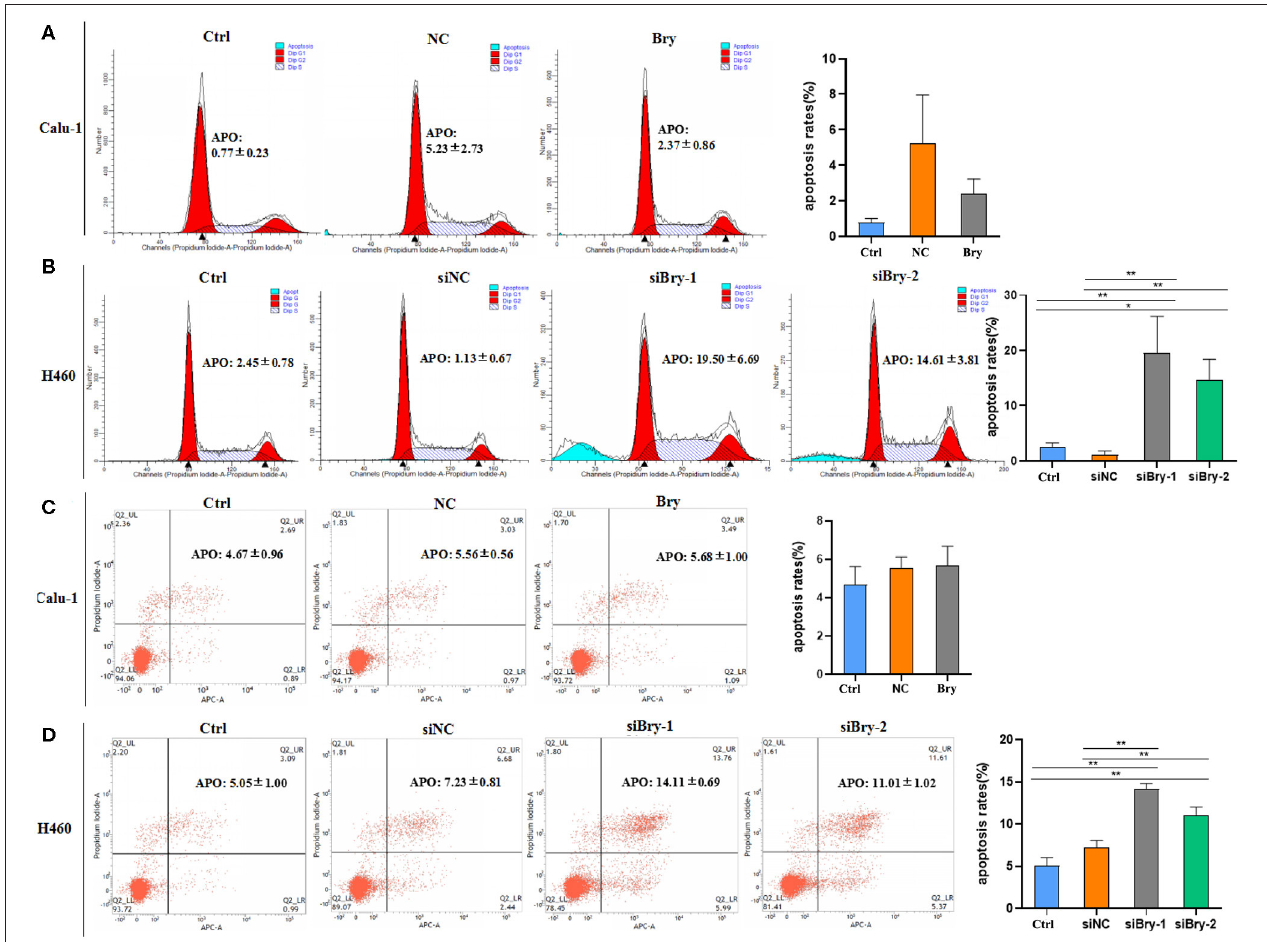
FIGURE 4 | The effect of Bry on cell apoptosis. (A) The effect of Bry on apoptosis of Bry-overexpression Calu-1 cells. There was no significant difference between the experimental group and the control group. (B) The effect of Bry on apoptosis of Bry-knockdown H460 cells. (C) Annexin V/PI method to analyze the effect of Bry on apoptosis of Bry-overexpression Calu-1 cells. There was no significant difference between the experimental group and the control group. (D) Annexin V/PI method to analyze of the effect of Bry on apoptosis of Bry-knockdown H460 cells (* P < 0.05, ** P <